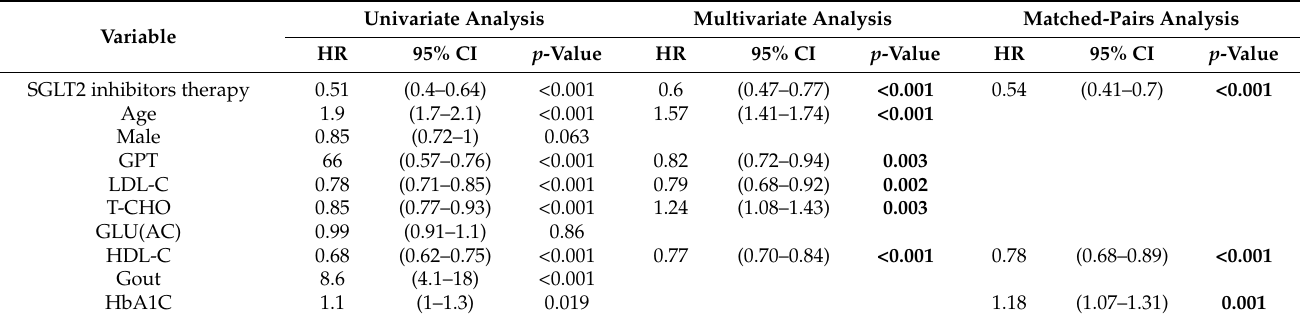
Table 5. Univariate and multivariate analyses of heart failure incidence in the study